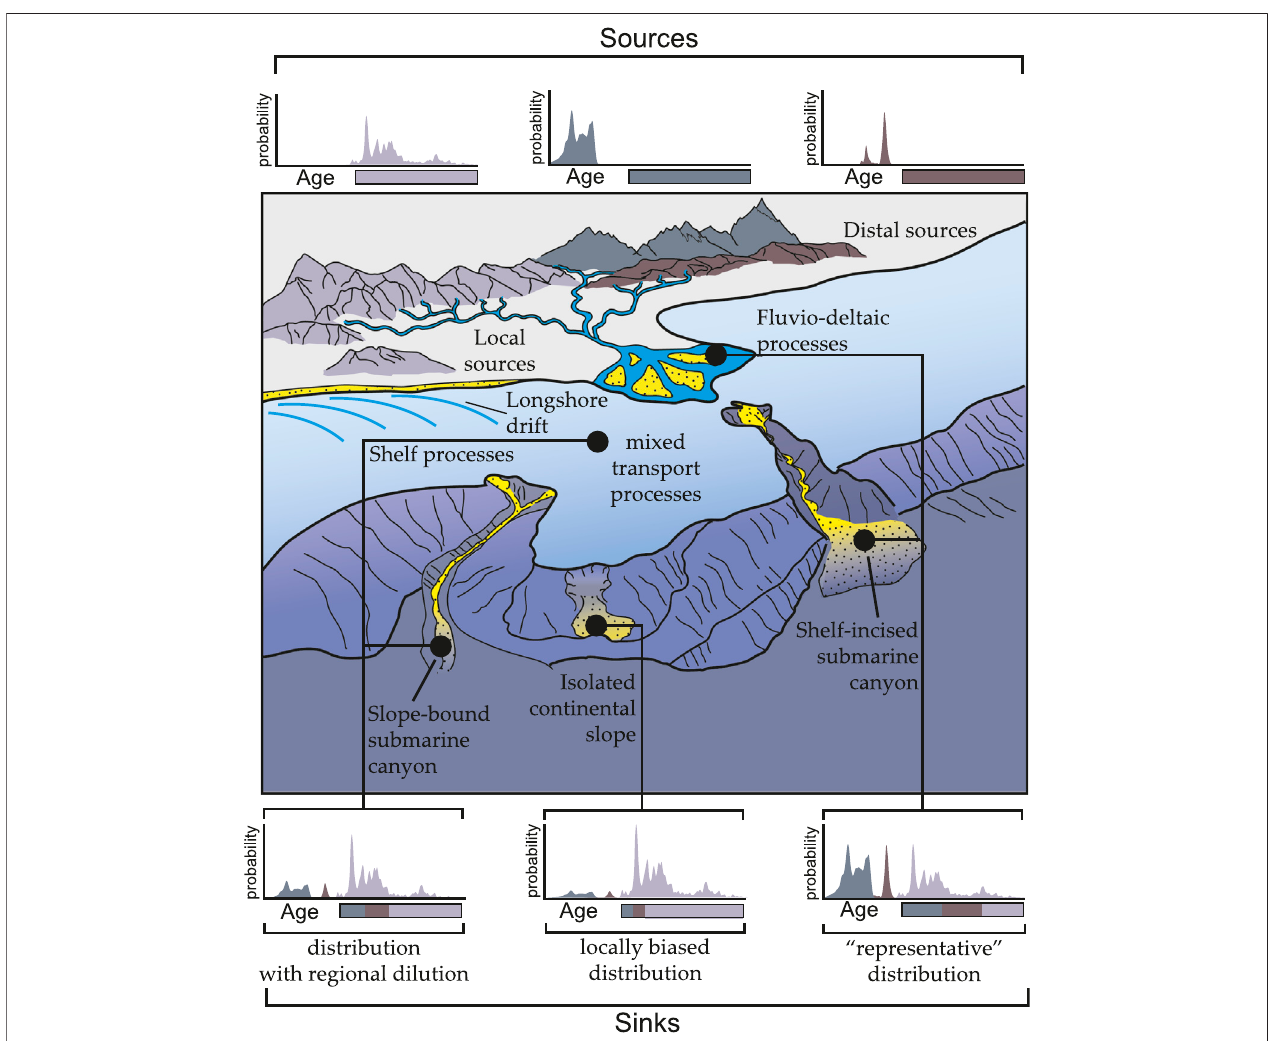
FIGURE 1 | Schematic illustration of a fi ctional source-to-sink model and resultant detrital zircon age distributions across different depositional environments. Sourcesarerepresentedbydifferentonshorewatershedswithvaryingdetritalzirconagedistributions.Thedown-slopesinksrepresentthepossibleshiftsinprovenance spectracausedbytheinterplayofseveraltransportanderosionprocesses.Notethatwhileashelf-connected submarinecanyonsystemmayhaveasimilarspectrumto its fl uvio-deltaic sources that are able to provide distally derived sediments, disconnected portions of the shelf and slope may record disparate age signals that are biased by local